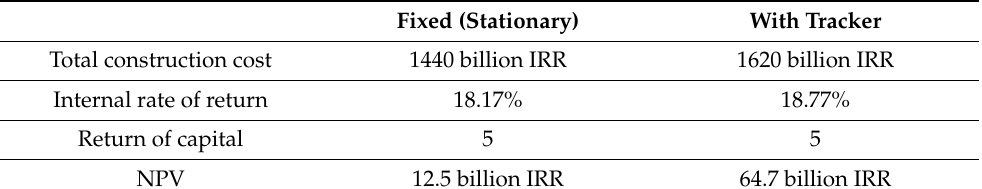
Table 9. Economic comparison of 10 MW power plants with/out trackers.